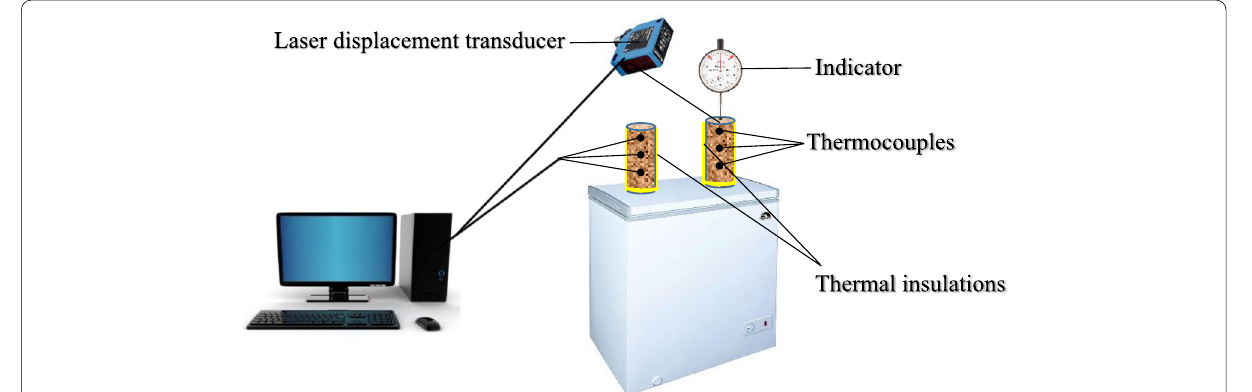
Fig. 1 The schematic picture of the experimental system measuring the frozen soil